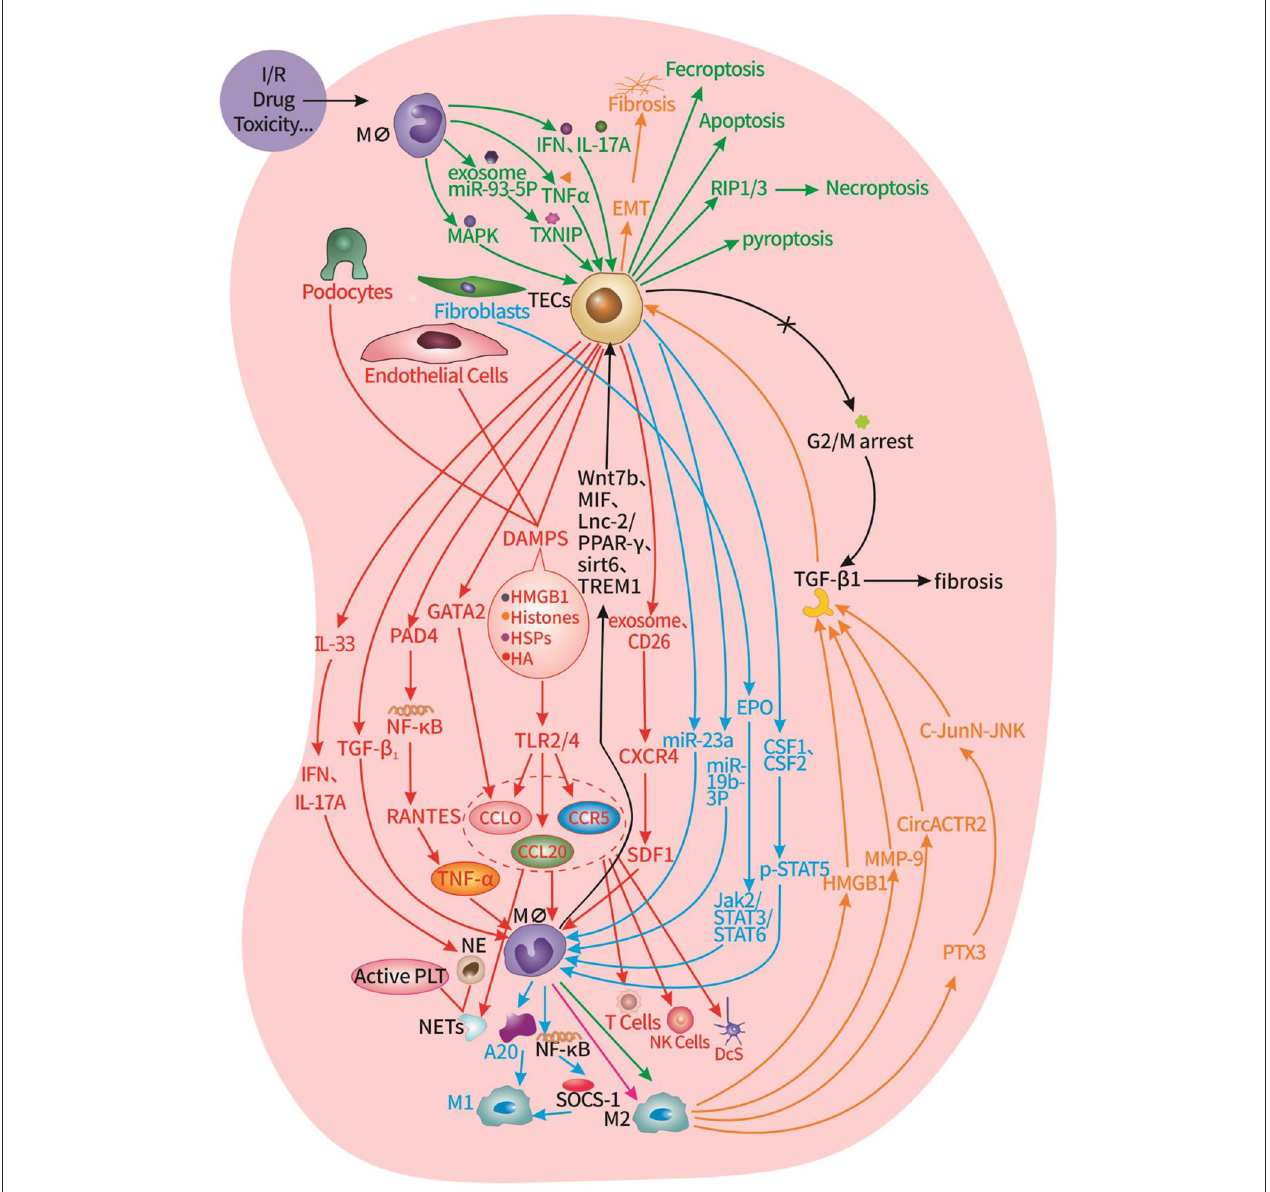
FIGURE 1 | Interaction of innate cells and immune cells in the renal microenvironment of AKI. Red part: TECs, podocytes, endothelial cells promote the infiltration of macrophages, neutrophils, T cells, NK cells, DCs, and the formation of NETs. Blue part: TECs, fibroblasts promote the transformation of macrophages into M2 type. Green part: macrophages promote TECs apoptosis, pyroptosis, necroptosis, and ferroptosis. Orange part: macrophages promote TECs EMT. Black part: macrophages inhibit G2/M cycle arrest of